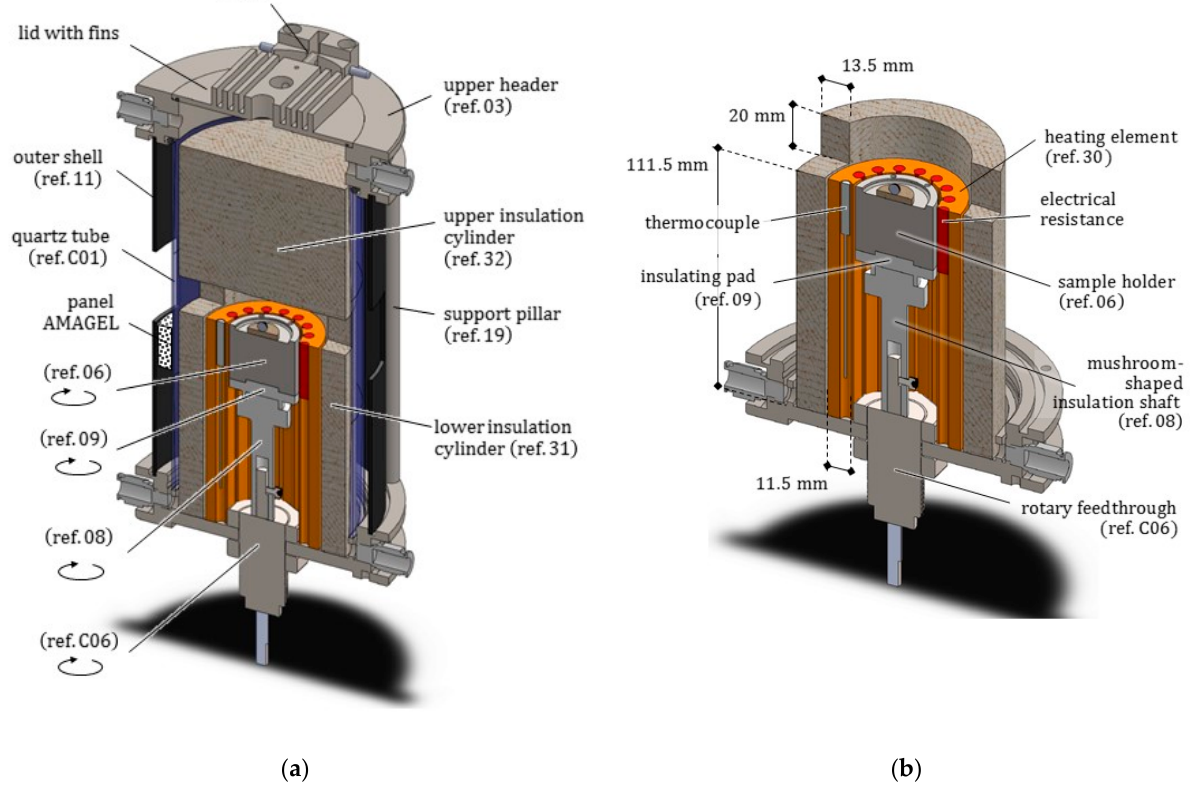
Figure 5. ( a ) Axonometric view of the entire furnace, longitudinally sectioned, with all the coaxial layers. The circular arrows specify the components rotating during the acquisition step. ( b ) Detail of the heating element (ref. 30) surrounding the sample holder (ref. 06) with its rotation transmission system, both enclosed by the insulation layer with the two openings for the X-rays beam. In both the headers, the two lateral connections for the inert gas pipes appear sectioned.